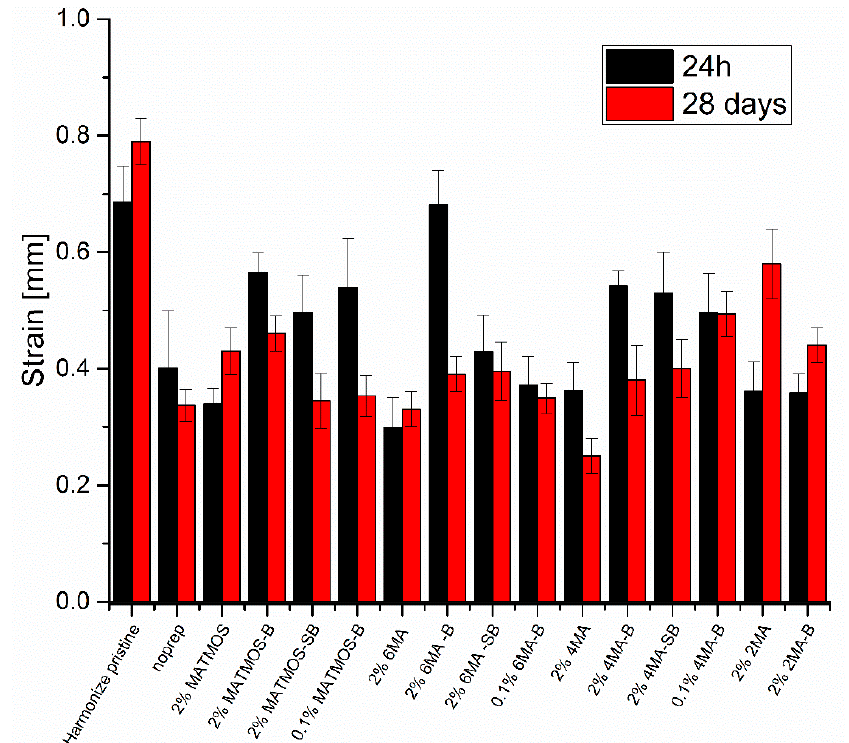
Figure 7. Strain of composite materials before and after priming and repair.